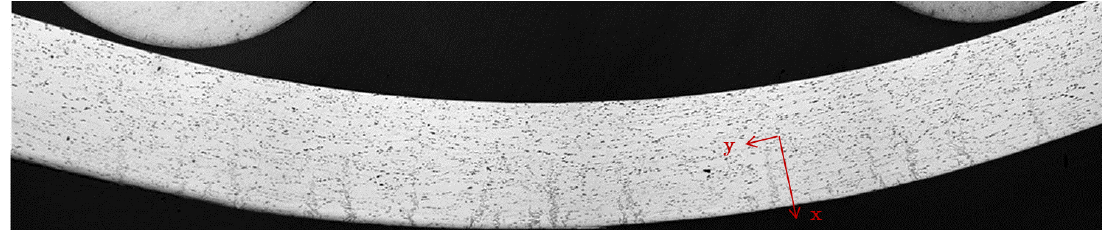
Figure 2. Bright-field optical micrograph of the sample in 4-point bending. The axis in red indicates the orientation of the EBSD measurement.